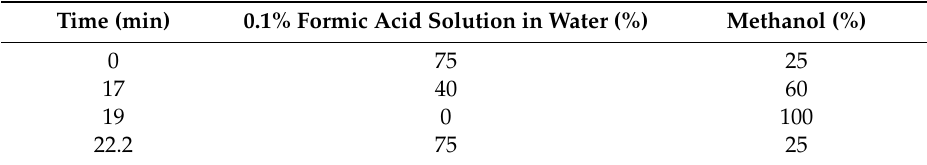
Table 2. The mobile phase conditions of ultra-high-performance liquid chromatography